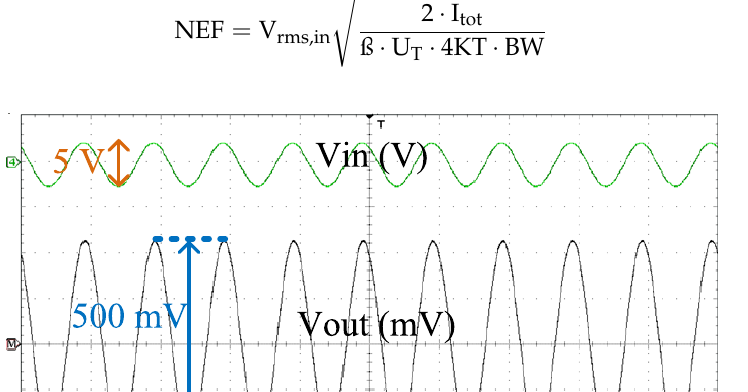
Table 1 for a resistive and a capacitive load of 10 M Ω and 95 pF, respectively. Although the proposed design achieves high-CMRR, it consumes relatively large amount of power compared to similar designs, as a result of using three amplification stages to increase the CMRR. Therefore, and to provide a fair comparison, we considered a figure of merit (FOM), which is the noise efficiency factor (NEF) as shown in Equation (17) [17]. The NEF of the proposed design is 29.8.